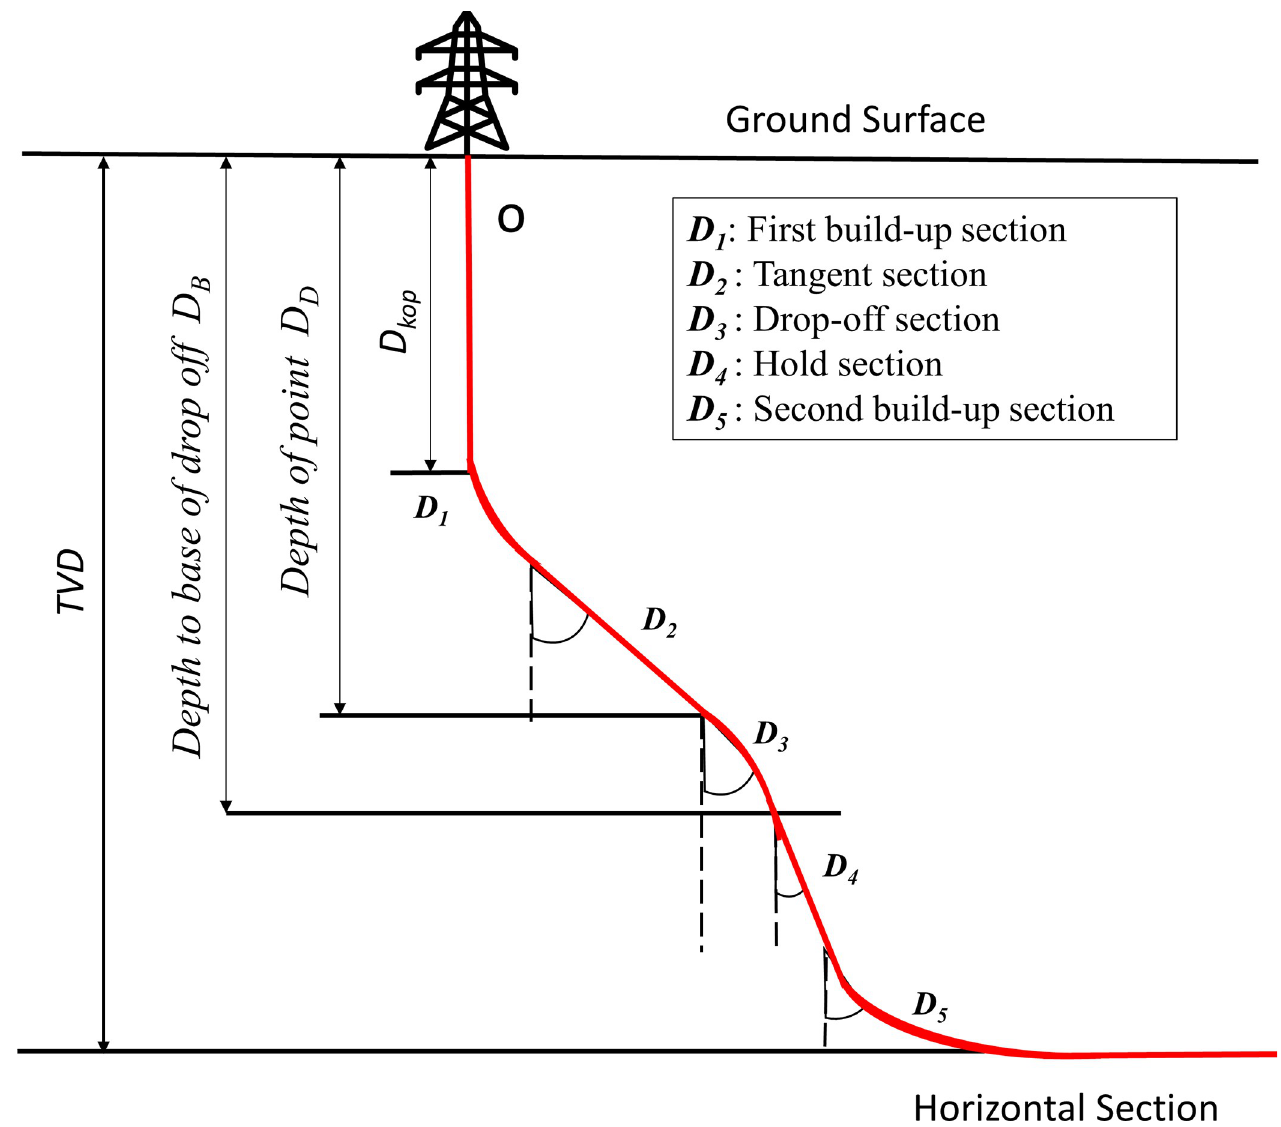
Fig 1. An overview of the wellbore trajectory. https://doi.org/10.1371/journal.pone.0261427.g001 According to Fig 1, the TMD’s fundamental equation is composed of seven segments which are represented by Eq (4).